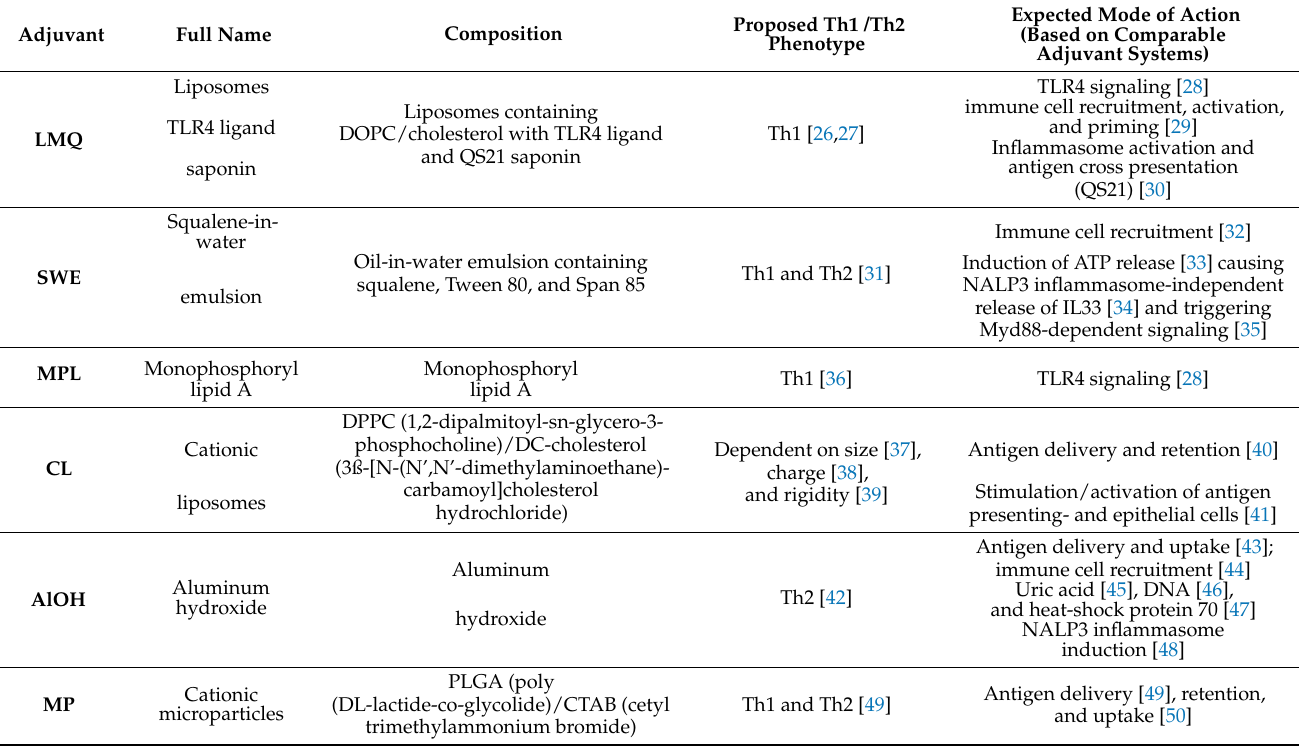
Table 1. Overview of the extrinsic adjuvants used in present